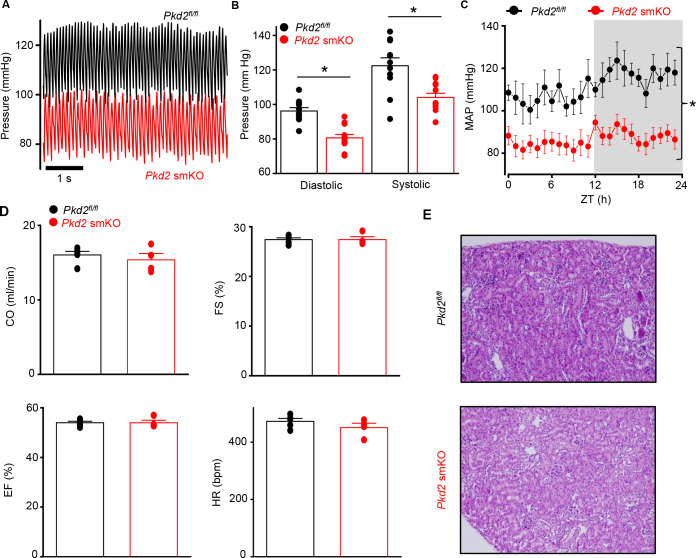
Pkd2 smKO mice are hypotensive with normal cardiac function and renal histology.(A) Original telemetric blood pressure recordings from Pkd2 smKO and Pkd2fl/fl mice. (B) Mean systolic and diastolic blood pressures in Pkd2fl/fl (n = 11) and Pkd2 smKO (n = 12) mice. * indicates p<0.05 versus Pkd2fl/fl. (C) Mean arterial blood pressures (MAP) in Pkd2fl/fl (n = 11) and Pkd2 smKO (n = 12) mice during day and night (gray) cycles. ZT: Zeitgeber Time. * indicates p<0.05 versus Pkd2fl/fl for all data points. (D) Mean echocardiography data. Cardiac output (CO), fractional shortening (FS), ejection fraction (EF) and heart rate (HR). (Pkd2fl/fl, n = 5; Pkd2 smKO mice, n = 4). (E) Representative images of H and E stained kidney cortex used for histological assessment (n = 3 mice used for for each group).